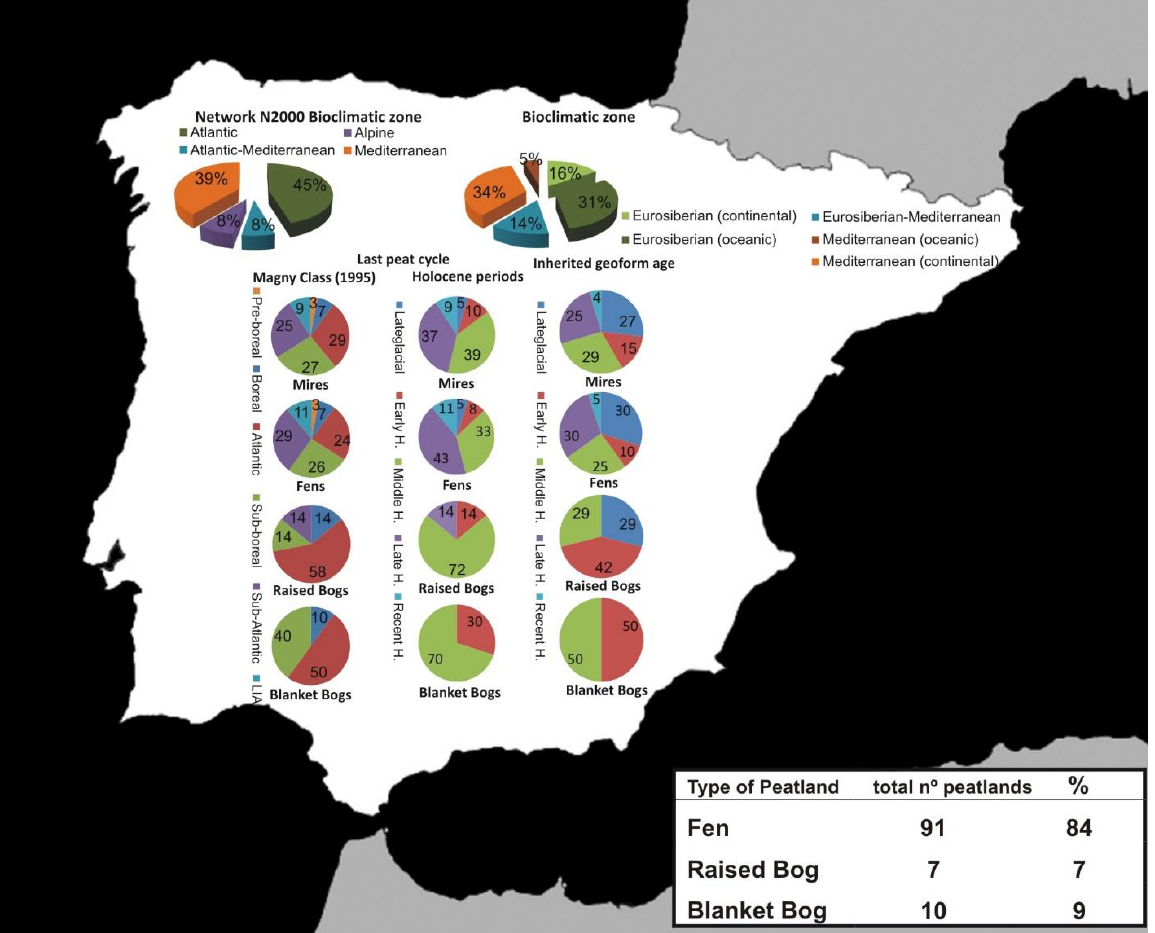
Figure 2. Typological, chronological and geographical distribution of peatlands in the Iberian